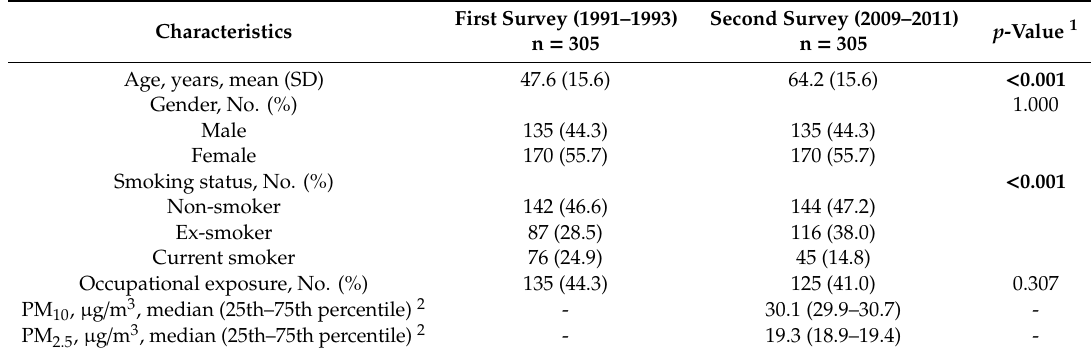
Table 1. Characteristics of the study sample at the two surveys.